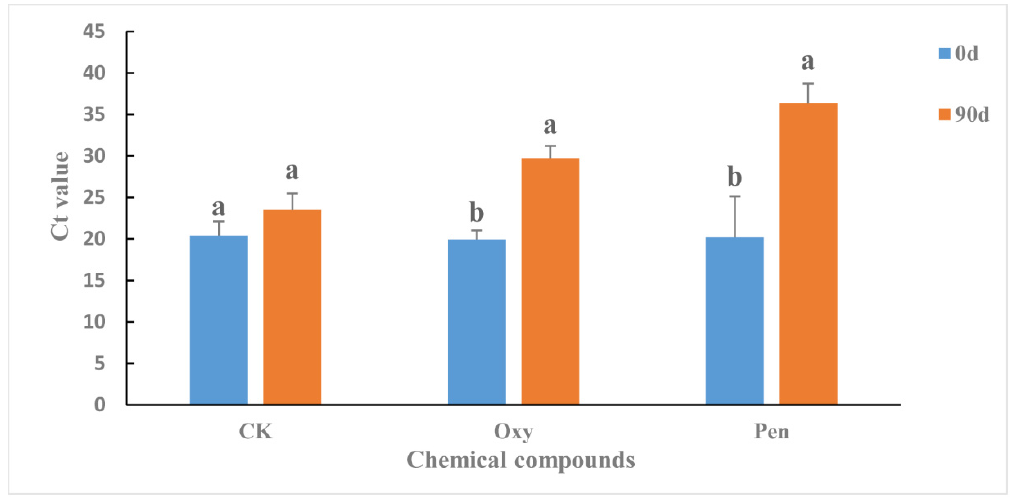
Figure 1. Ct value in HLB-affected citrus treated with oxytetracycline (Oxy) and penicillin (Pen). Different letters represented significantly differences at the level of 0.05 ( p ≤ 0.05).